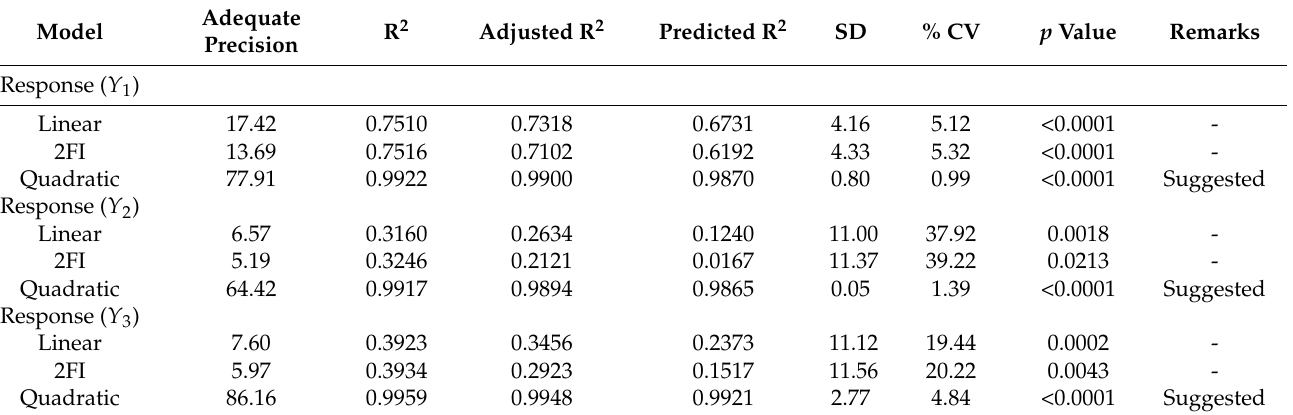
Table 3. Regression analysis results for PRZ-PMMs responses Y 1 , Y 2 and Y 3 for data fitting to various